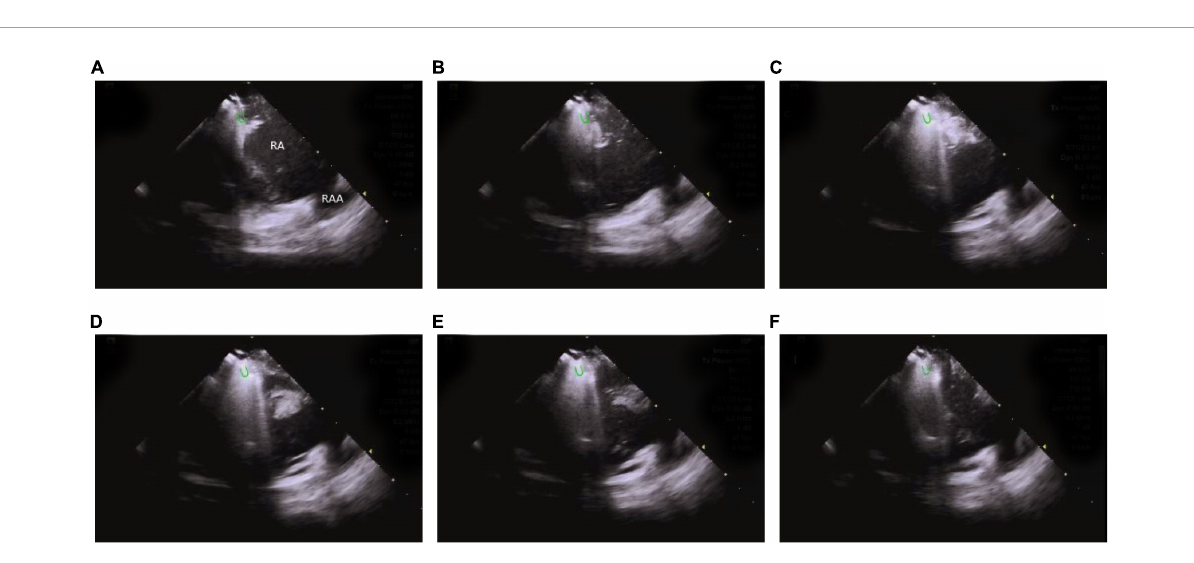
FIGURE13 Steam-pop formation during RF (A–F) . (A,B) The microbubbles were observed before steam pop; (C–F) ICE imaging showed that the formation suddenly expanded to a sphere over the course of several seconds. Green semi-ellipse: the positions of the ablation catheter tip; RA, right atrial; RV, right ventricle; RAA, right atrial